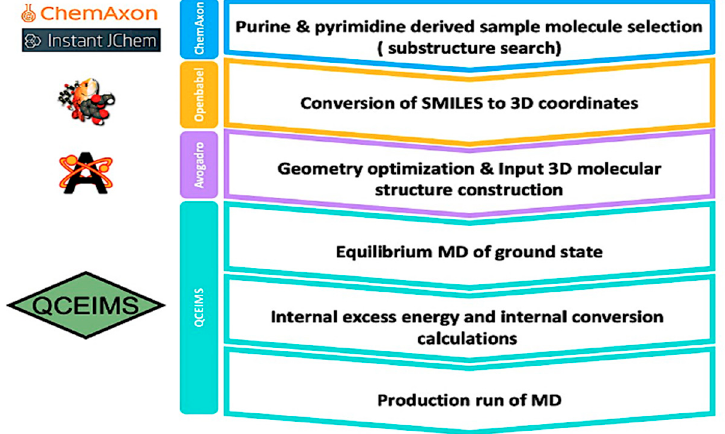
Figure 1. Overall workflow from selection of molecules to generating QCEIMS mass spectra.